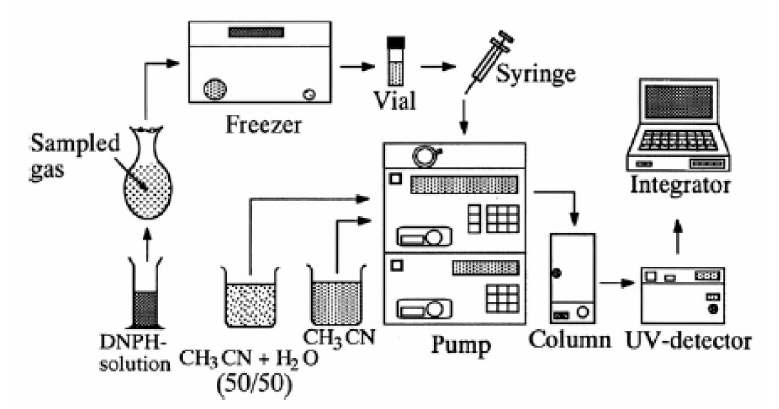
Figure 4. Schematic diagram of